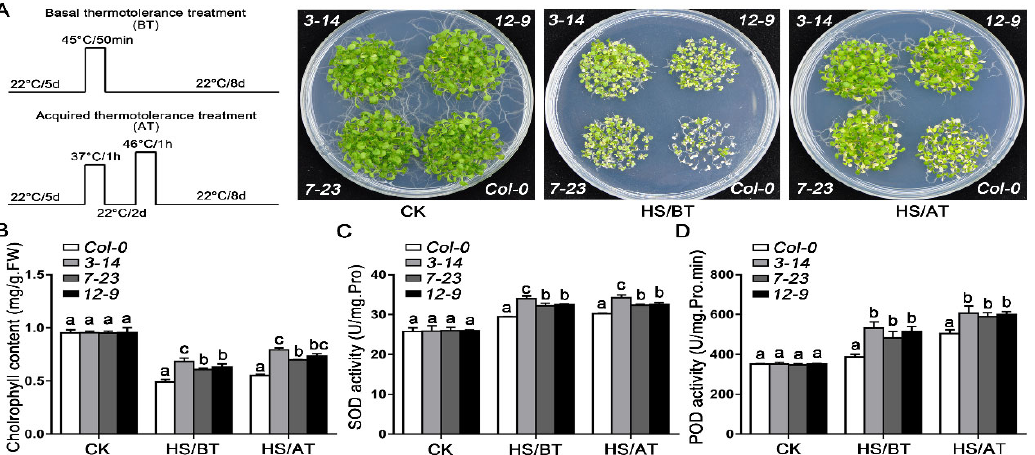
Figure 5. Thermotolerance assays of TaHsfA2-7-AS in Arabidopsis . ( A ) The phenotypes of WT and transgenic seedlings after basal thermotolerance (BT, 45 ◦ C for 50 min, placed at 22 ◦ C for 8 days) and acquired thermotolerance (AT, 37 ◦ C for 1 h, incubated at 22 ◦ C for 2 days, 46 ◦ C for 1 h, placed at 22 ◦ C for 8 days) treatment. The plants were photographed 8 d after different HS. ( B ) Chlorophyll content of WT and transgenic seedlings treated with different HS. ( C , D ) POD and SOD activities of WT and transgenic seedlings under HS treatment or not. For each experiment, at least 30 plants per line were used. Values are means ± SD from three independent measurements. Different lowercase letters above the bars denote significant differences at the p < 0.05 level.